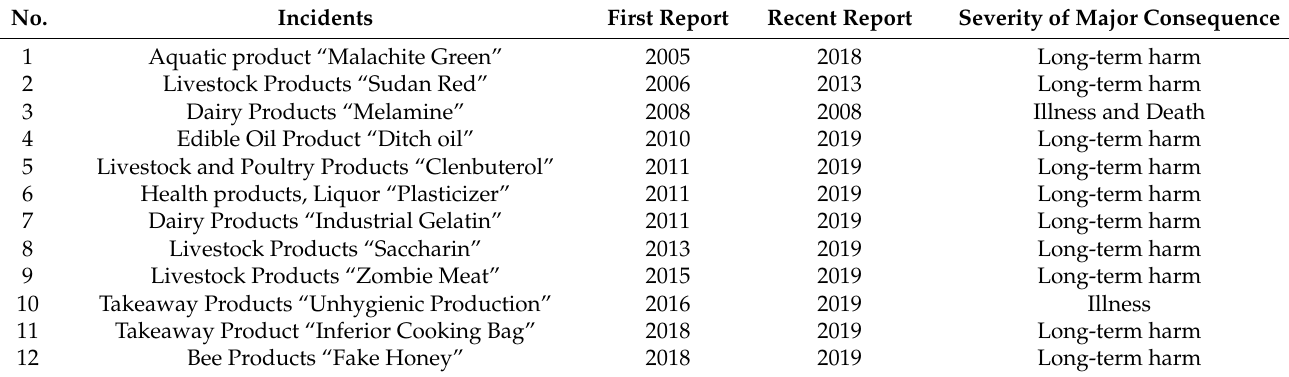
Table 1. Examples of the most concerning food fraud incidents in China from 2005 to